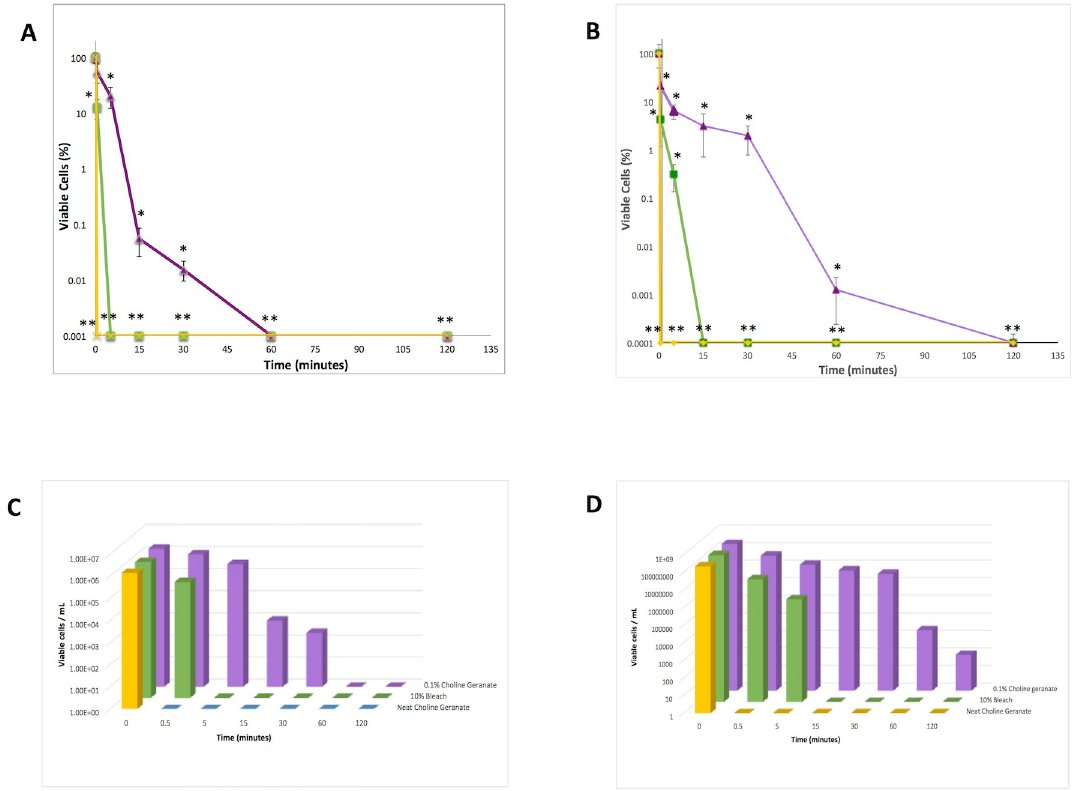
Fig 2. Cellular viability of MSSA biofilms vs time for exposures of neat CAGE (yellow), 0.1% CAGE (purple) and 10% bleach (green). Data is presented as calculated mean cellular viabilities ± standard deviation. A) Percent cellular viability for exposures on 24 hr biofilms, B) Percent cellular viability for exposures on 72 hr biofilms, C) Mean cellular viability vs exposure time for 24 hr biofilms, D) Mean cellular viability vs exposure time for 72 hr biofilms. Errors in a) and b) represent the standard error of the mean for n = 6, and statistical significance for all conditions compared to untreated controls were calculated via the Student’s t-test ( � p < 0.05, �� p < 0.01). Calculated means for data points in parts a and b vs time are presented in a logarithmic bar plot in parts c and d for the convenience of the reader. The lowest value on the y-axis of plots a and b represent the limit of detection of the implemented assay.